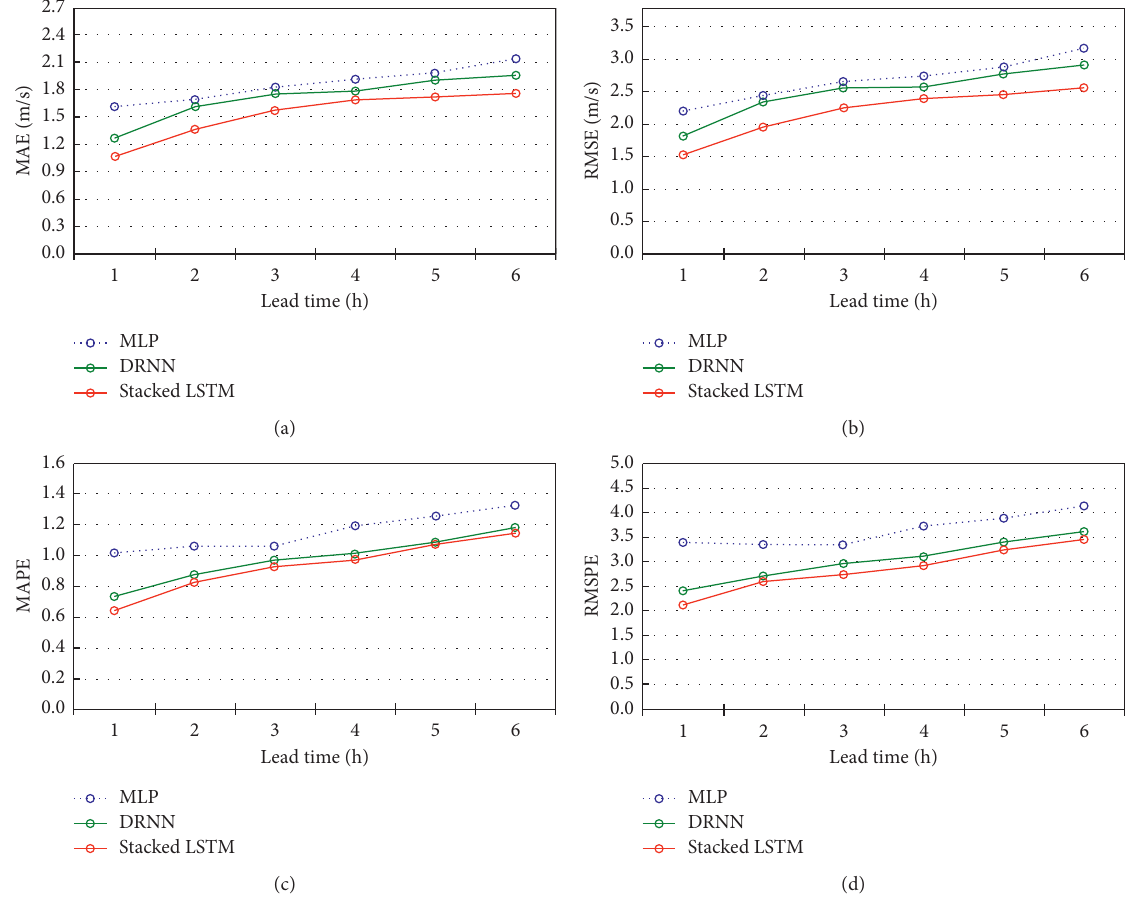
Figure 13: Performance measures at lead times from 1 to 6 h on the Yilan gauge: (a) MAE, (b) RMSE, (c) MAPE, and (d)